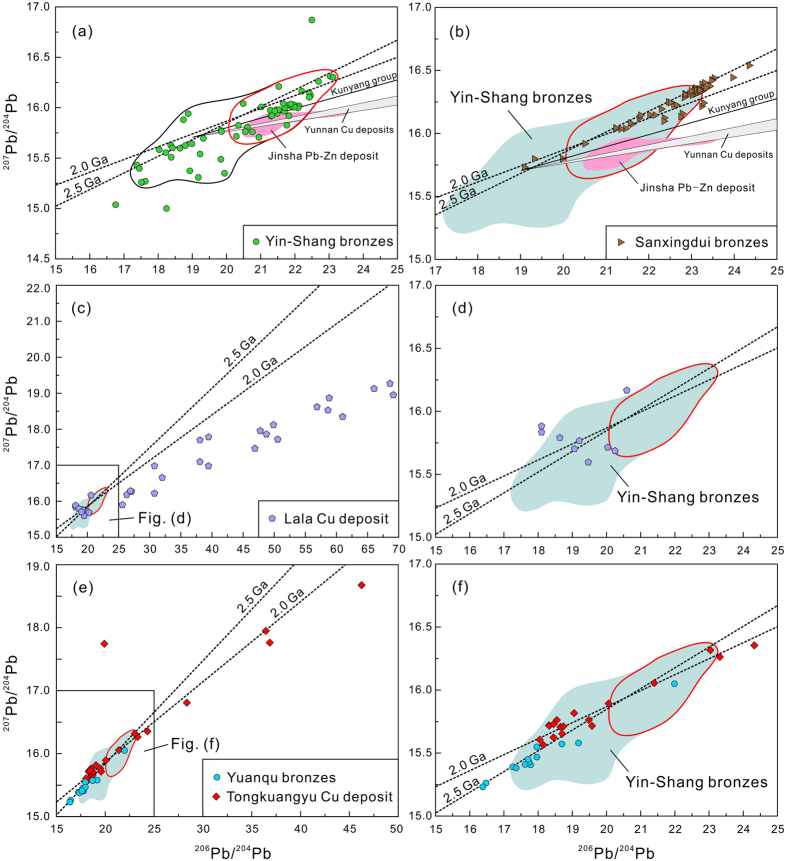
260Pb/204Pb versus 207Pb/204Pb diagram for ancient bronzes2795859 and ore deposits60 from China.Yin-Shang bronzes (black line marks the field for all Yin-Shang bronze samples so far published, red line marks the field for bronze with highly radiogenic lead isotopes) and Jinsha Pb-Zn deposit (a), Sanxingdui bronzes (b), Lala copper deposit in southwestern China, at the east margin of the Tibetan Plateau (c,d) and copper ores from Tongkuangyu deposit22 and bronzes from Yuanqu in central China2426 (e,f) (Supplementary Table). The 2.0 Ga isochron line is defined by South Africa bronze (Fig. 4), the 2.5 Ga line is defined by Sanxingdui bronzes.